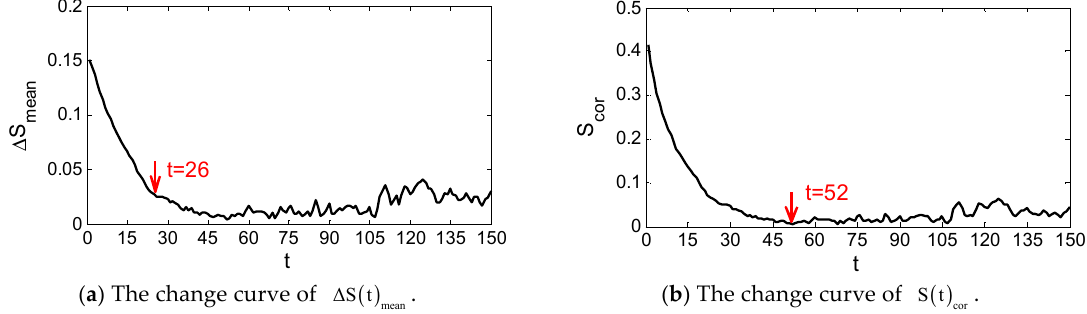
Figure 3. Results of ∆ S ( t )